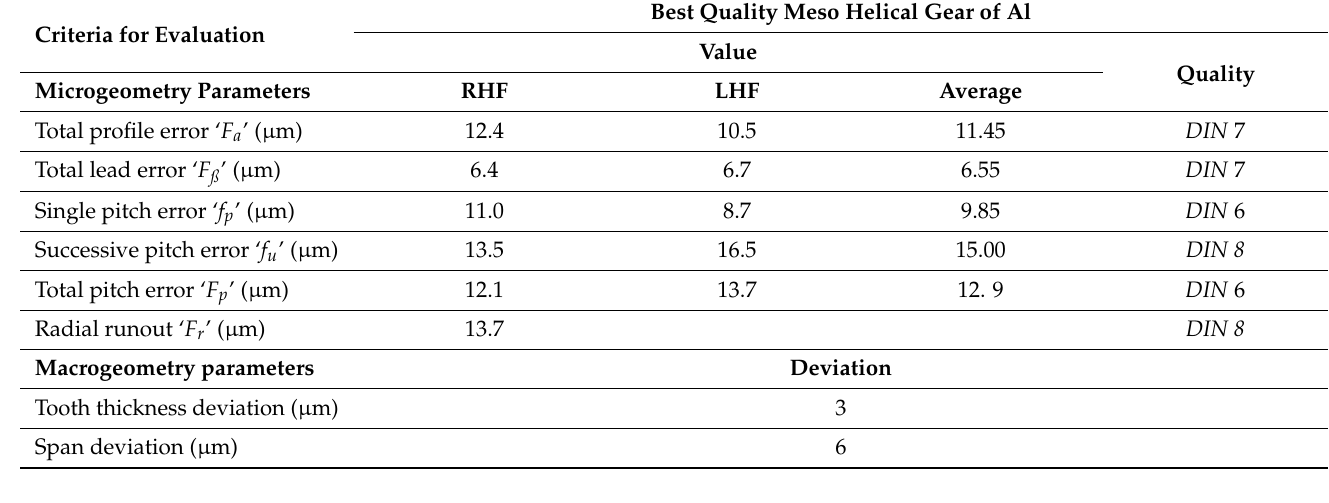
Table 3. Results of metrological inspections of the best finish miniature spur gears.